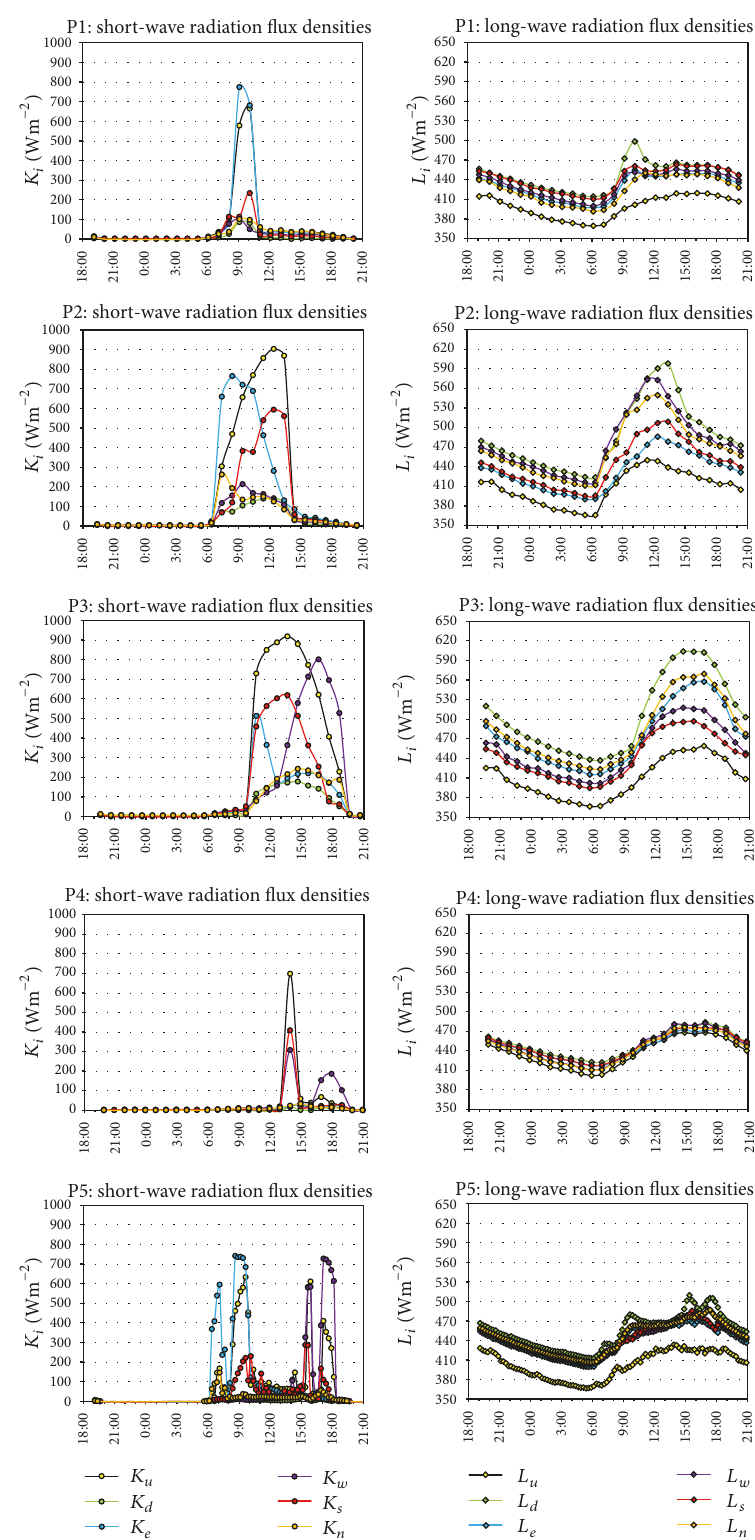
Figure 5: Short- ( 𝐾 𝑖 ) and longwave ( 𝐿 𝑖 ) radiation flux densities measured at the five survey points (note: to better illustrate the site-related differences different scales were applied for the short- and longwave